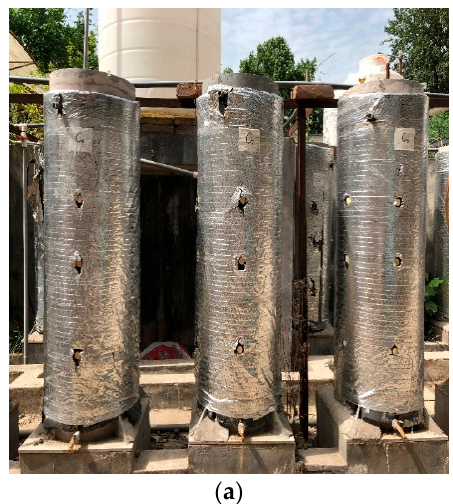
Table 2. The chemical and physical specifications of media.